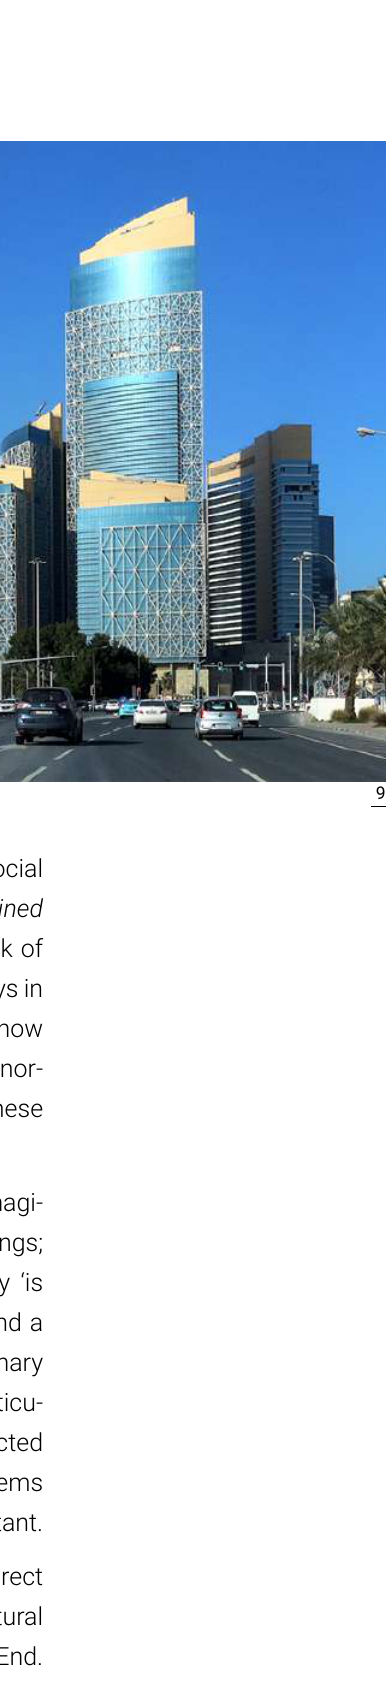
Photograph of QDP under construction (Source: Peter Chomowicz,